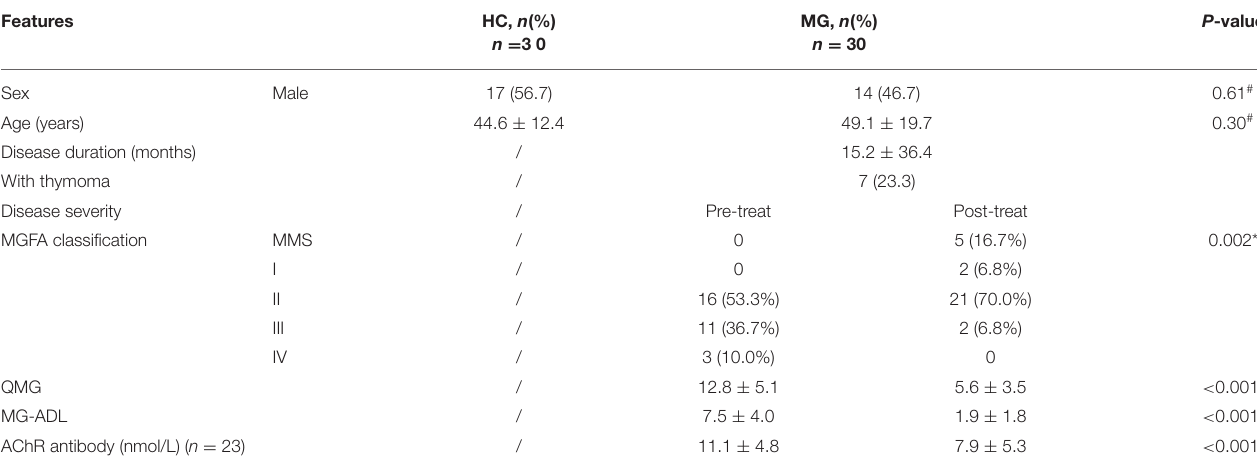
TABLE 1 | Summary of healthy controls and clinical features of 30 patients with MG.